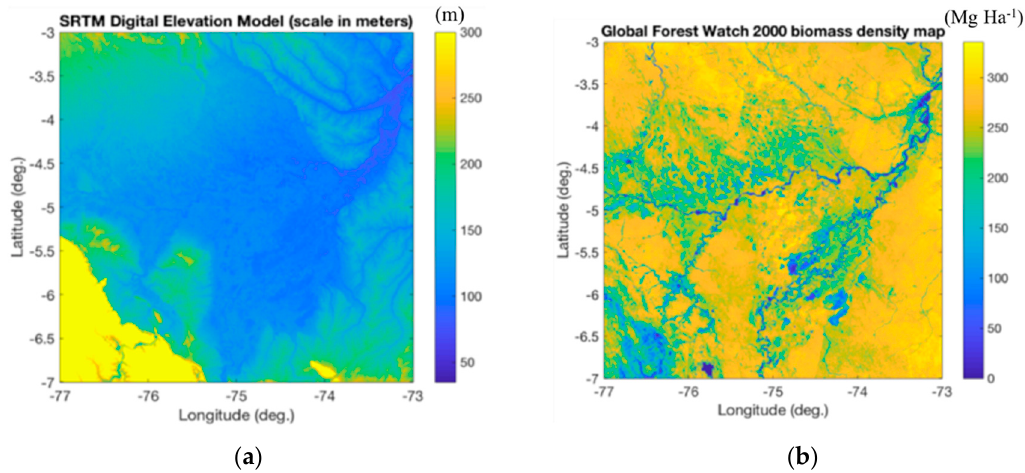
Figure 6. Ancillary data used in this study, ( a ) digital elevation model (DEM) from the Shuttle Radar Topographic Mission 90 m resolution (SRTM90) in meters, and ( b ) Global Forest Watch (GFW) biomass density (Mg / ha) map obtained from GFW. Both maps have been re-gridded to 0.005 × 0.005 deg. lat / lon to match the grid resolution of the